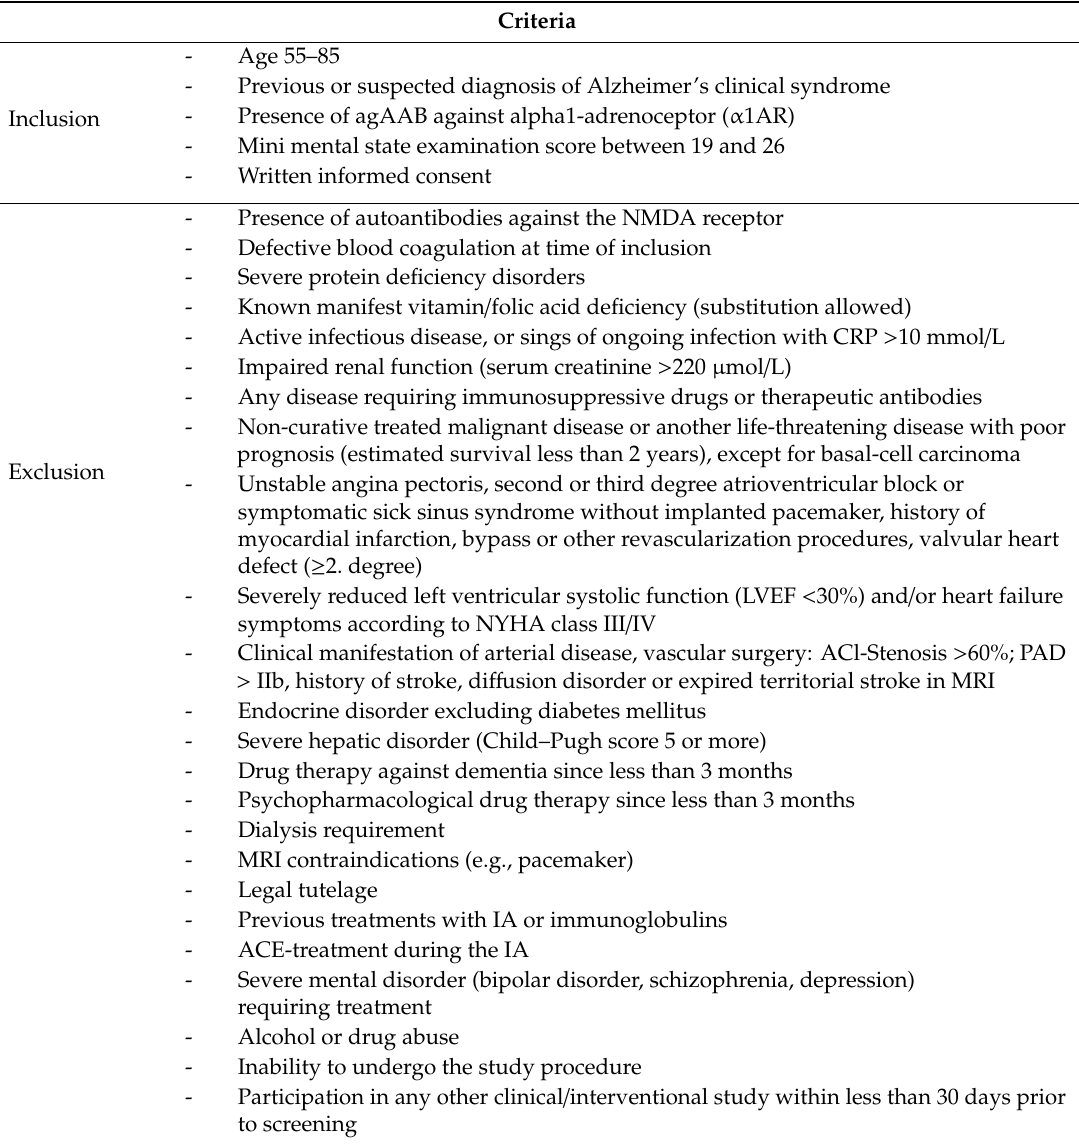
Table 1. Inclusion and exclusion